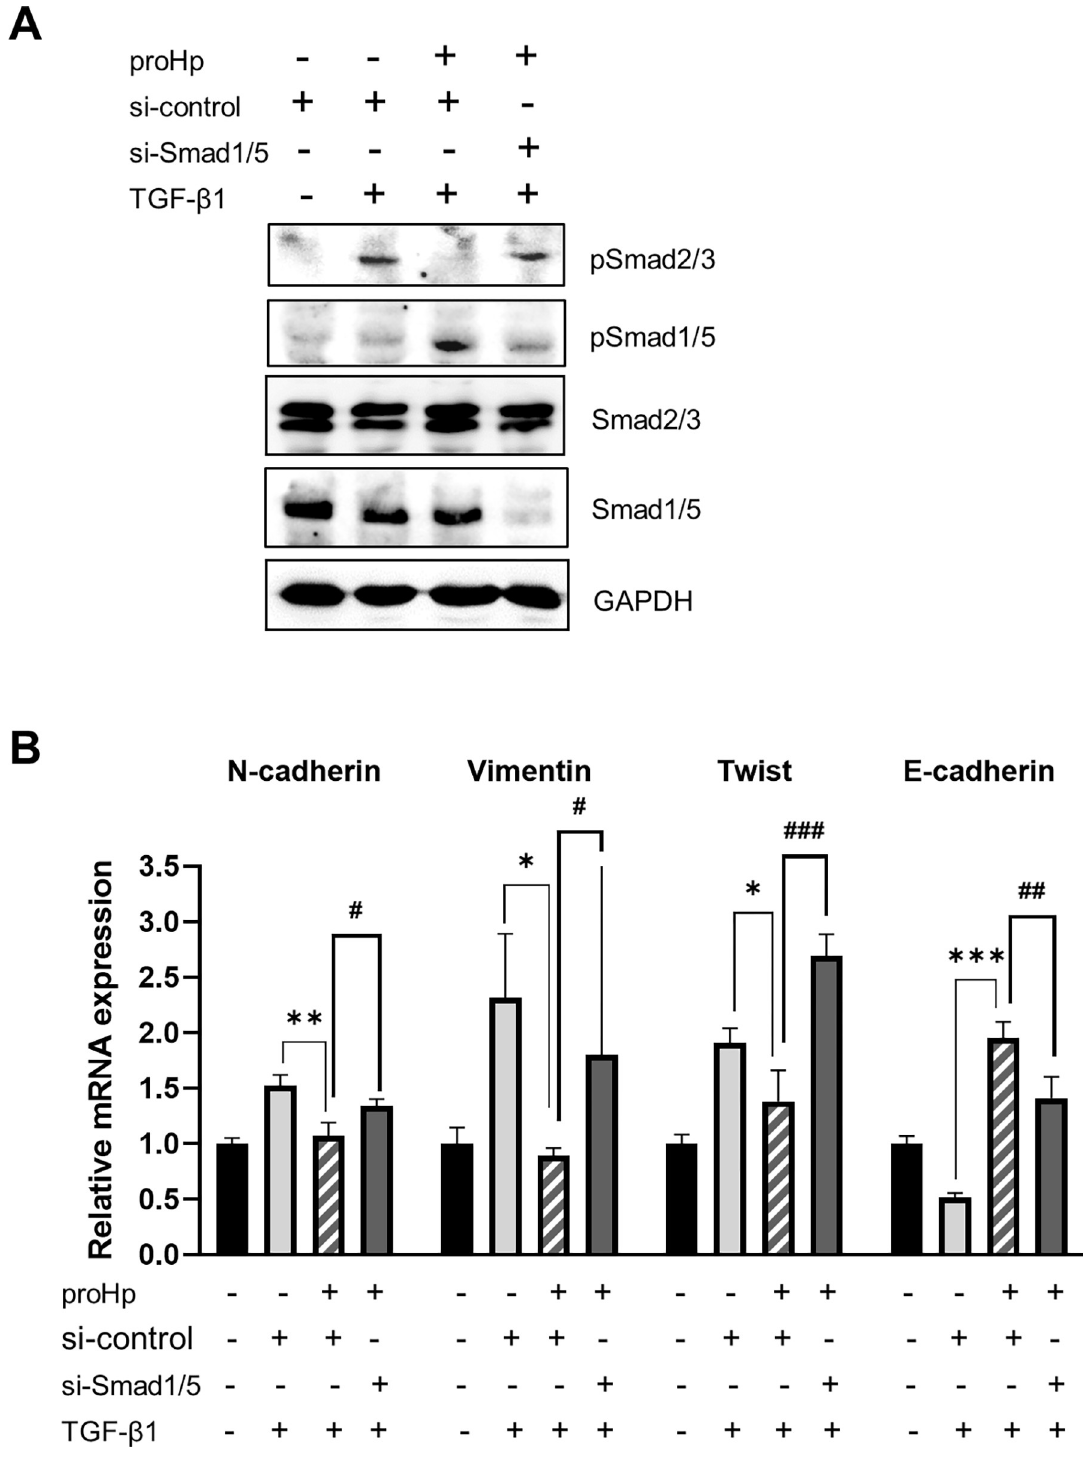
Fig 5. Smad1/5 knockdown recovers TGF- β -induced Smad2/3 activation in proHp-overexpressing cells. ProHp-overexpressing SK-Hep1 cells were transfected with control (si-control) or Smad1/5-targeting (si-Smad1/5) siRNA as described in the Materials and methods. (A) After serum-starvation for 3 h, the cells were stimulated with 5 ng/mL TGF- β for 1 h. Phosphorylation of Smad2/3 and Smad1/5 was analyzed by Western blotting. (B) After incubation of the gene-knockdown cells with 5 ng/mL TGF- β for 48 h, mRNA expression of N-cadherin, vimentin, twist, and E-cadherin was quantified by qRT-PCR. Expression levels were normalized to GAPDH.